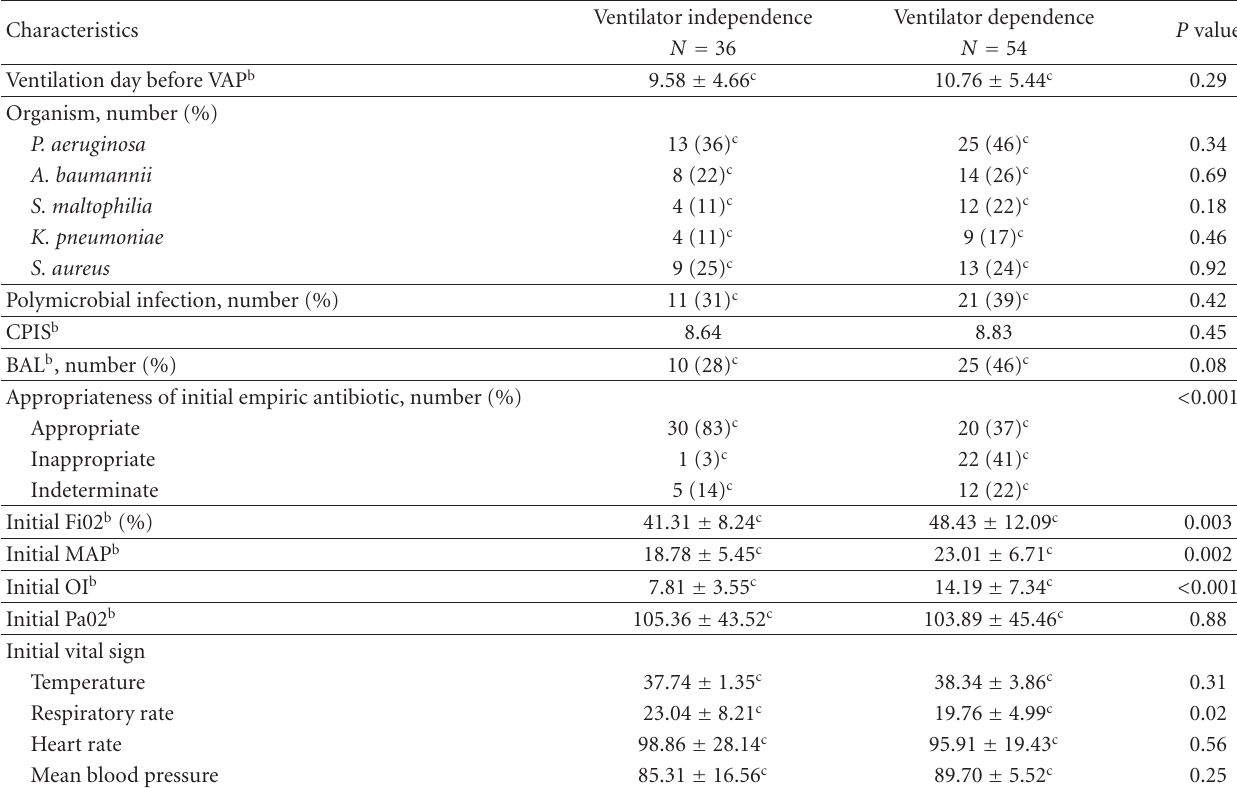
Table 3: Ventilator-associated pneumonia related characteristics a .